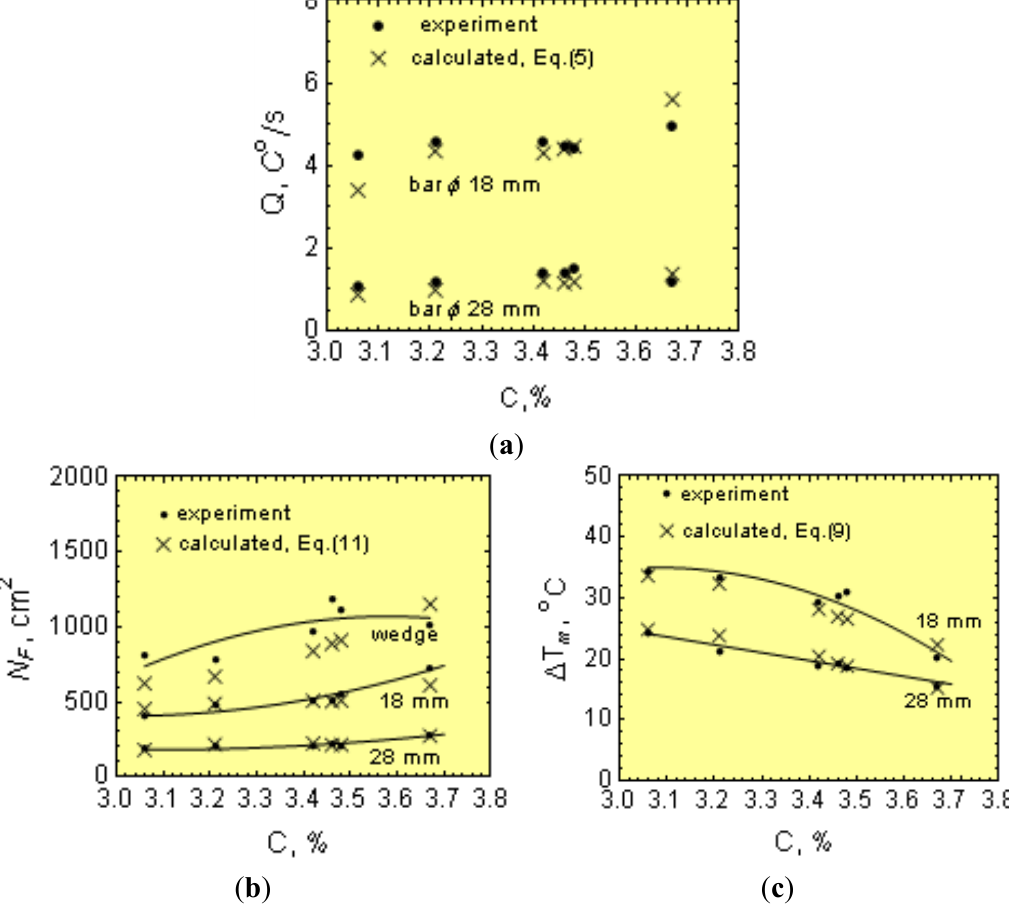
Figure 10. Effect of carbon on ( a ) the cooling rate, Q, of cast iron at the onset of solidification, ( b ) cell count and ( c )